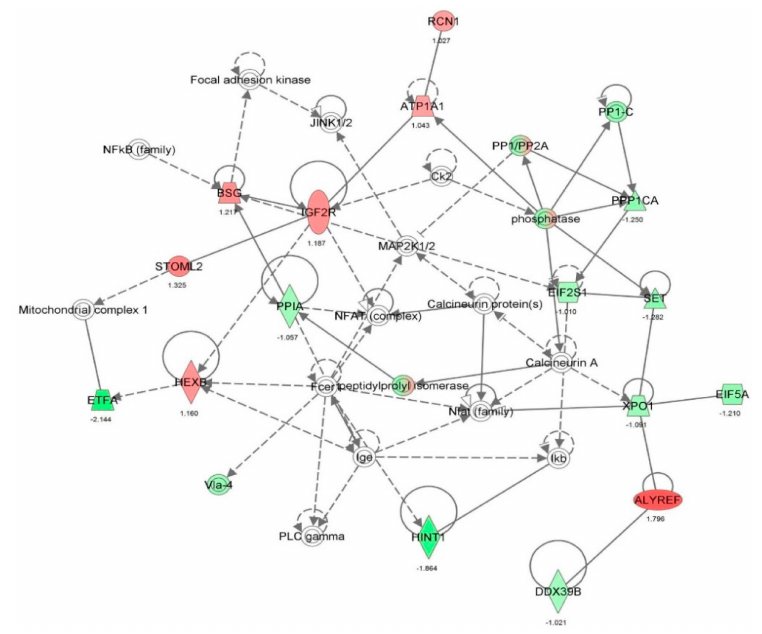
Figure 20. Vancomycin regulated molecular transport, RNA trafficking, and cell death and survival. Red indicates an up-regulation; green indicates a down-regulation. The intensity of green and red colors indicates the degree of down- or up-regulation. Solid arrow indicates direct interaction and dashed arrow indicates indirect interaction.